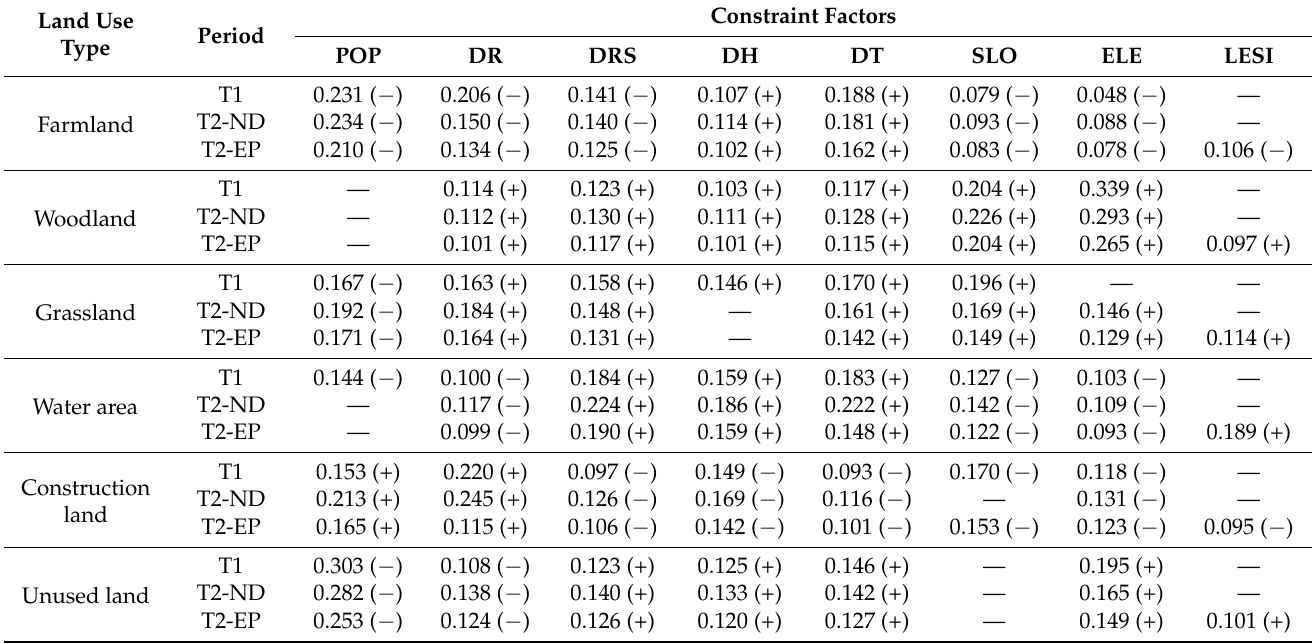
Table 3. Constraint factors and